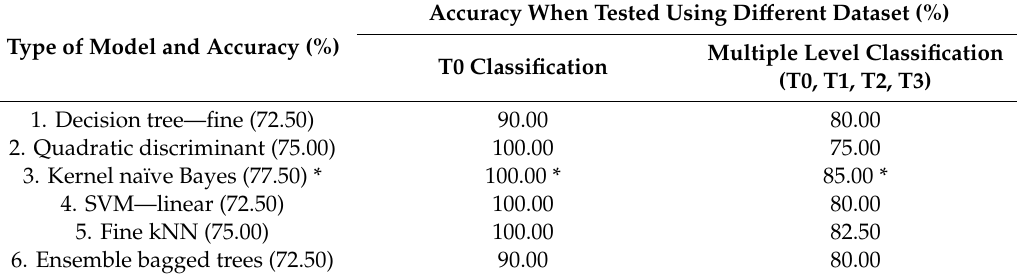
Table 4. Results of the classification model using PC1 and PC2 (variance of 73%).